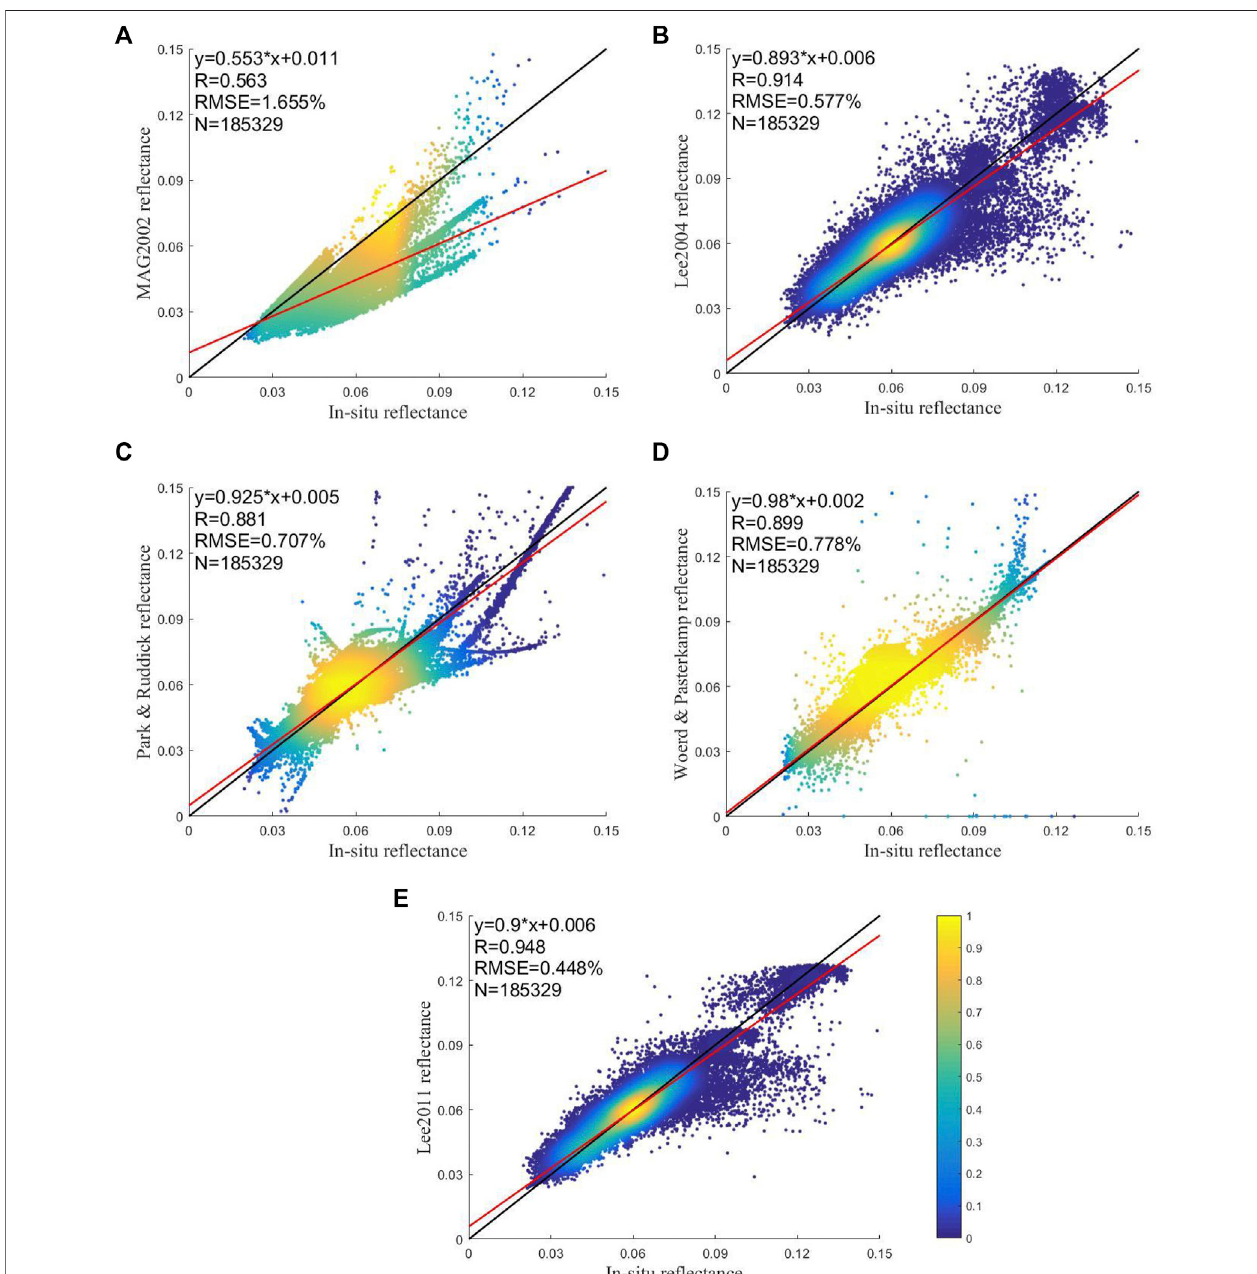
FIGURE7| ScatterdensityplotstocomparemodelsimulationsandmeasurementsattheGreenBandforTaihuLakeasawhole.Thevaluesarepresentedatlinear scales.Thesolidredcolorlinesinthe fi guresarethe fi ttinglines.Thesolidblacklinesarethereferencelinesof1:1.Thecolorsindicatetheproportionalnumberagainstthe maximumofobservationsonthescale.Thelinear fi ttingformula(y),thecorrelationcoef fi cient(R),theroot-mean-squareerror(RMSE),andthenumberofmeasurements (N) are displayed on the upper left section of each